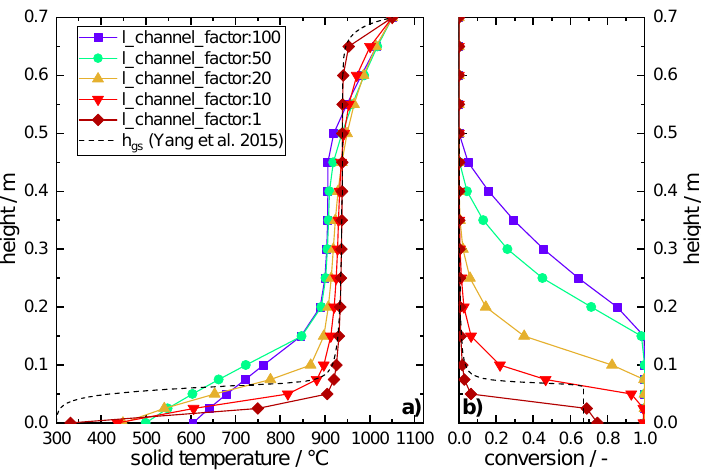
Figure 11. A variation of the channeling ratio ζ between 1 (no channels) and 100 (channels with 100 times length of d p ). ( a ) Solid temperature profile of the stationary moving bed with 4g/s in counter-current to an air flow rate of 190.8L/min and ( b ) the conversion profile of the Mn-Fe-oxide